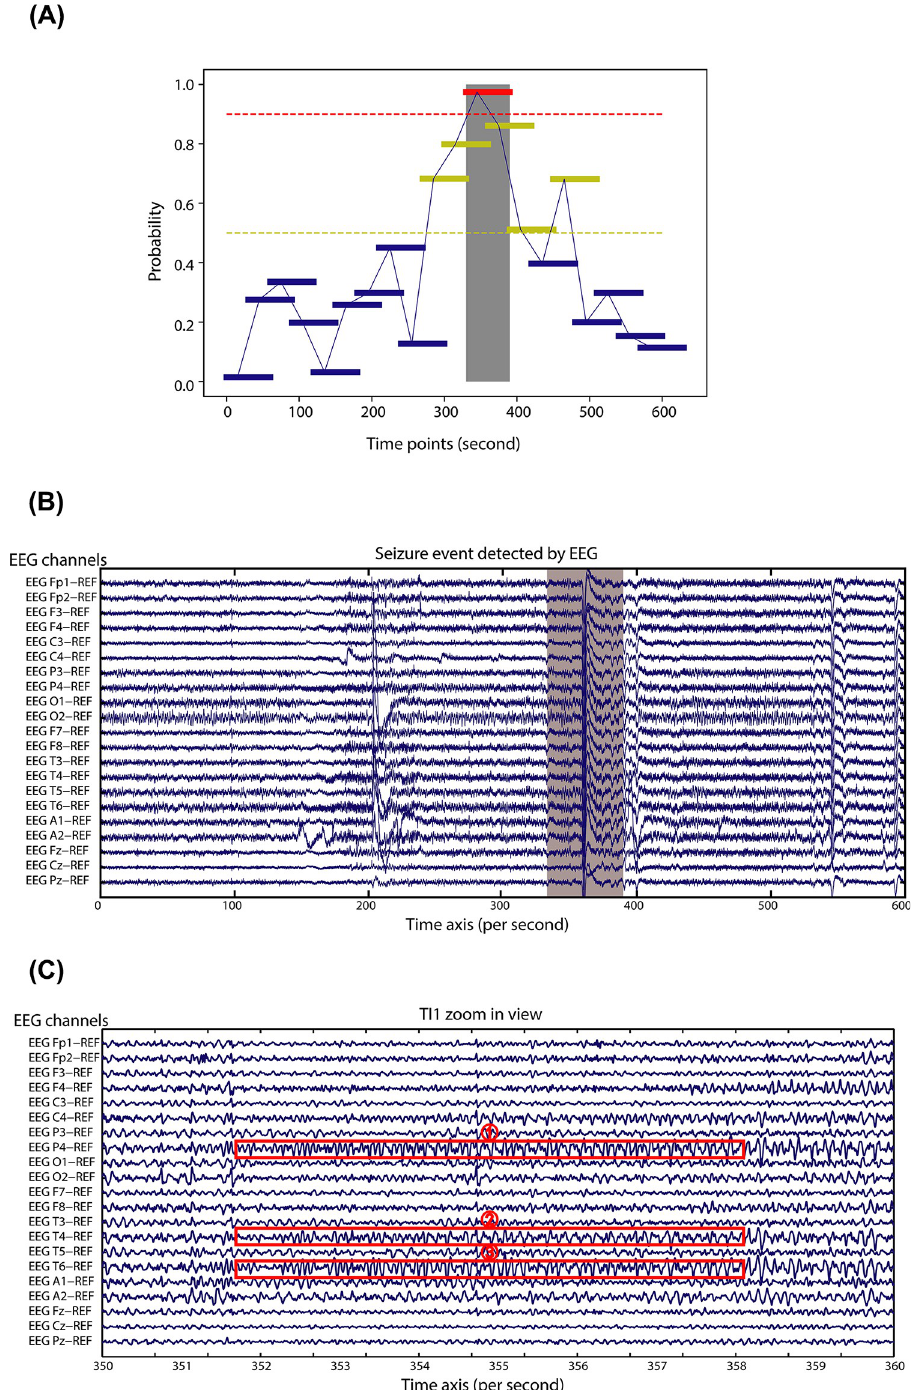
Fig 6. Real-time monitoring during a seizure event. ( A ) Real-time monitoring during a seizure event. The red horizontal bar in the grey box represents a true seizure event, the dark yellow horizontal bars represent “false alarms”, and the blue horizontal bars represent true negative events. ( B ). EEG signals during a seizure event. ( C ). Zoomed in view of EEG signals during the seizure event (TI1).